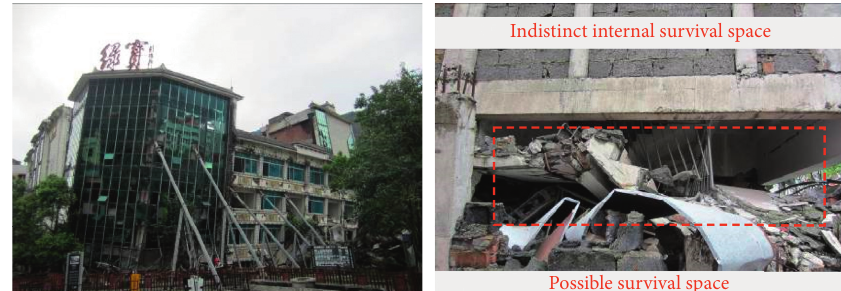
Figure 2: The final collapse state and possible survival space of the Lvbao hotel building (the pictures from author Dai Junwu).